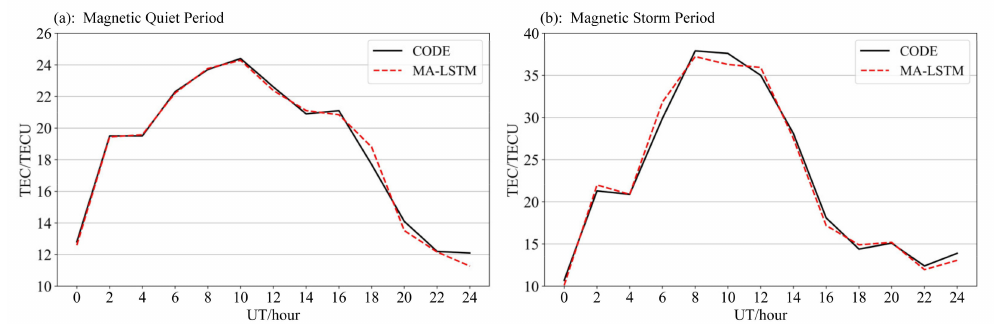
Figure 11. Comparison of the predictive performance of a ( a ) magnetic quiet day and a ( b ) magnetic storm